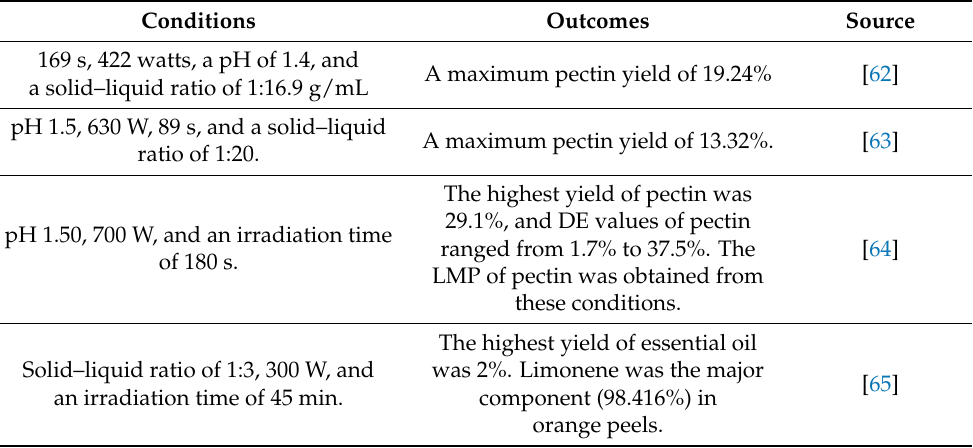
Table 2. The optimal parameters and outcomes in orange peel extraction by MAE. Conditions Outcomes